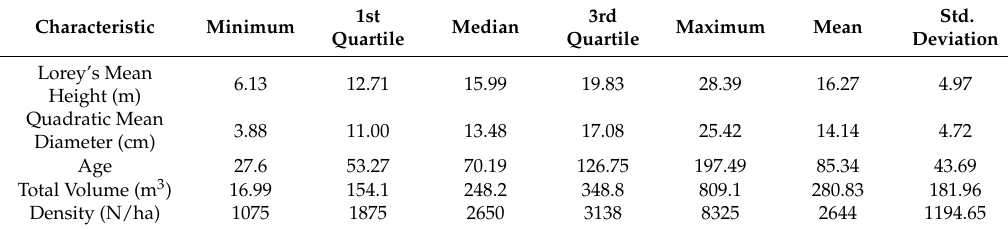
Table 1. Summary of plot measurements ( n = 71).